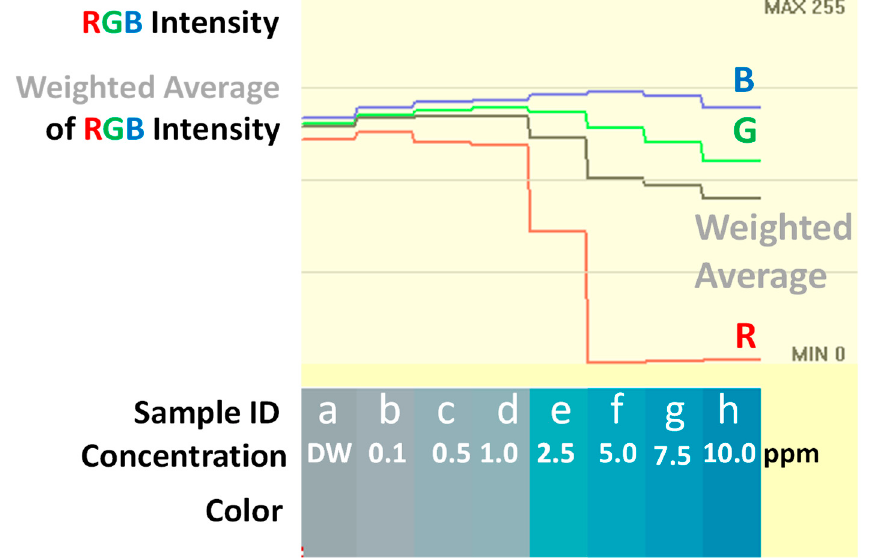
Figure 8. Representation of MB solutions from 0.1 to 10 ppm (adapted from [23] color and RGB values and weighted RGB values extracted using PicMan). The weighted average of RGB values were calculated by using a formula (R + 2G + B)/4.